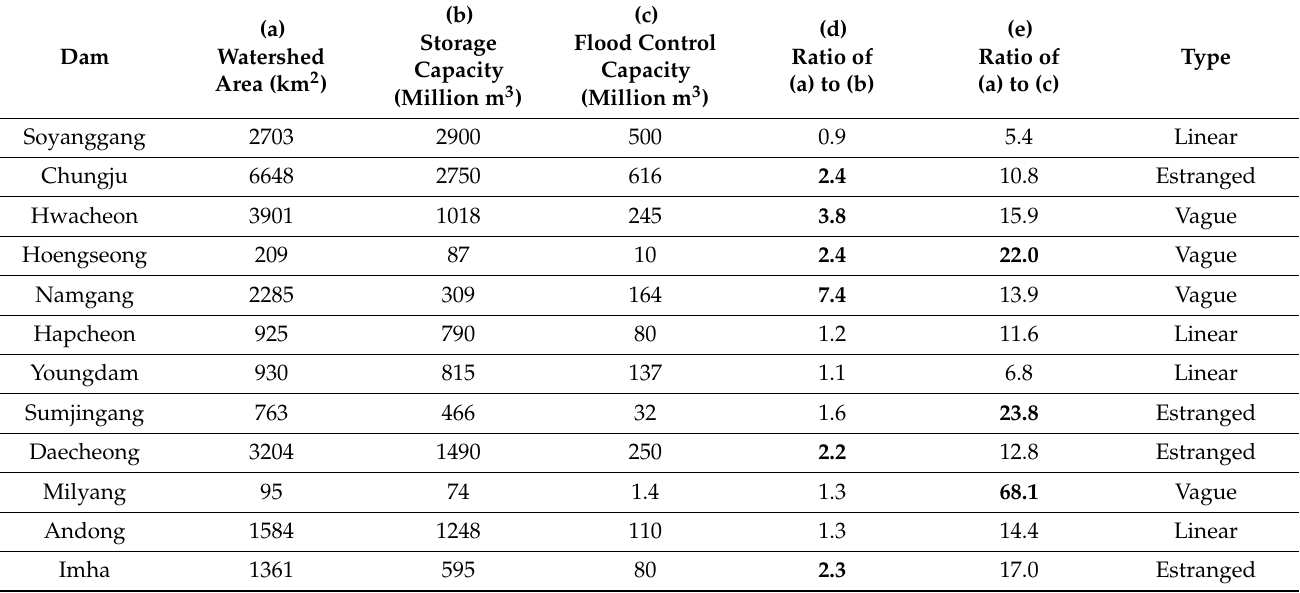
Table 1. The ratio of watershed area, storage, and flood control capacity of each